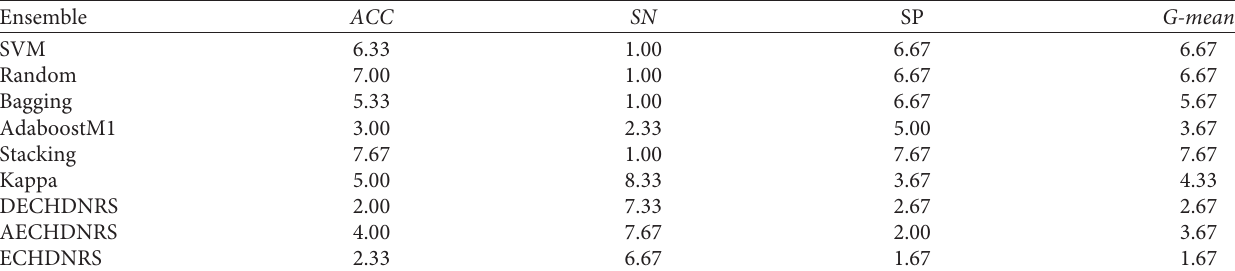
Table 8: Average ranking on three